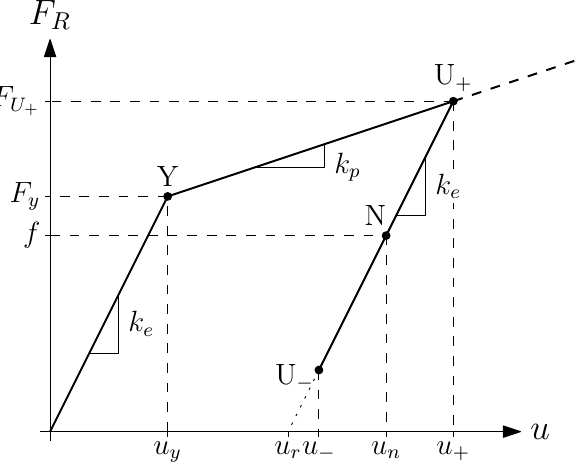
Figure 3. Elastic-plastic law of the connecting device. Explanations of the letters in the plot are reported in the